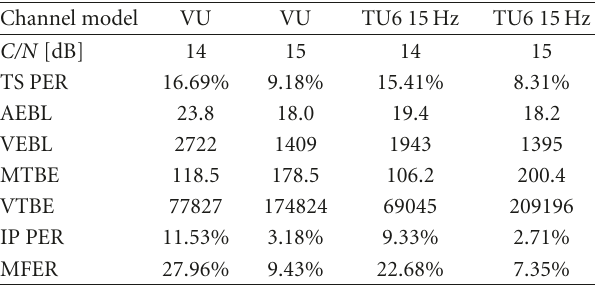
Table 6: Error statistics for VU and TU6 15Hz channels at C/N 14 dB and 15